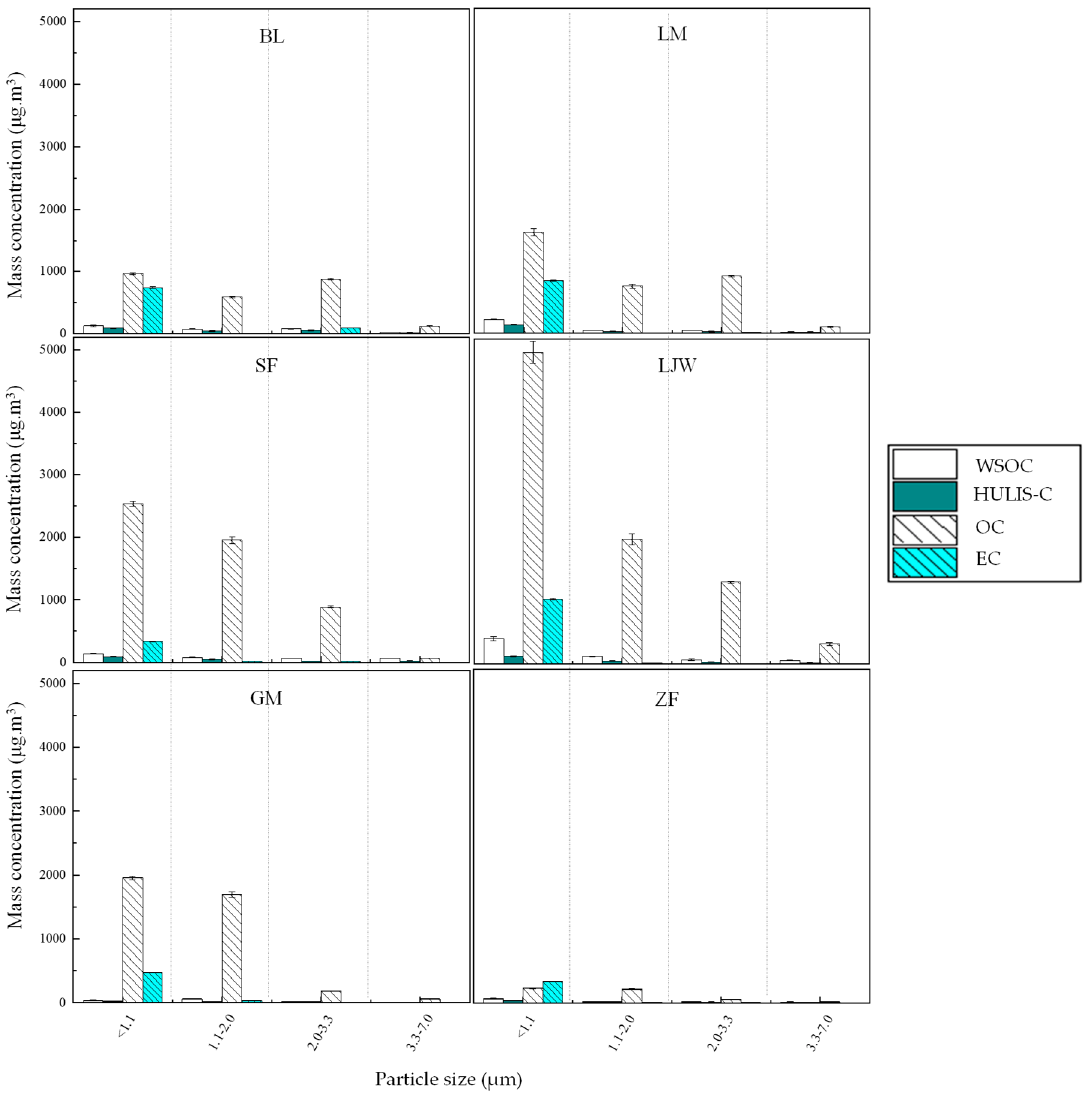
Figure 7. Mass concentration ( µ g m − 3 ) and standard deviation (STD) of OC, EC, WSOC, and HULIS-C (Coal, N = 6) in RCC particles. (Bole coal (BL), Luomu coal (LM), Shunfa coal (SF), Lijiawu coal (LJW), Guangming coal (GM), and Zongfan coal (ZF)).